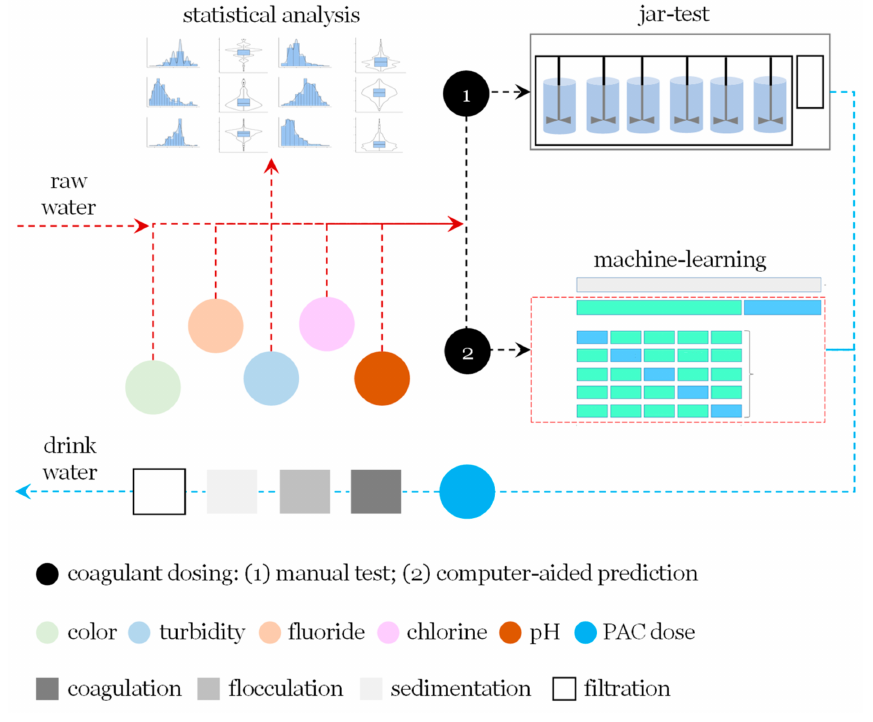
Figure 2. WTP via conventional treatment (coagulation–flocculation–sedimentation–filtration) with manual or computer-aided coagulant dosing.